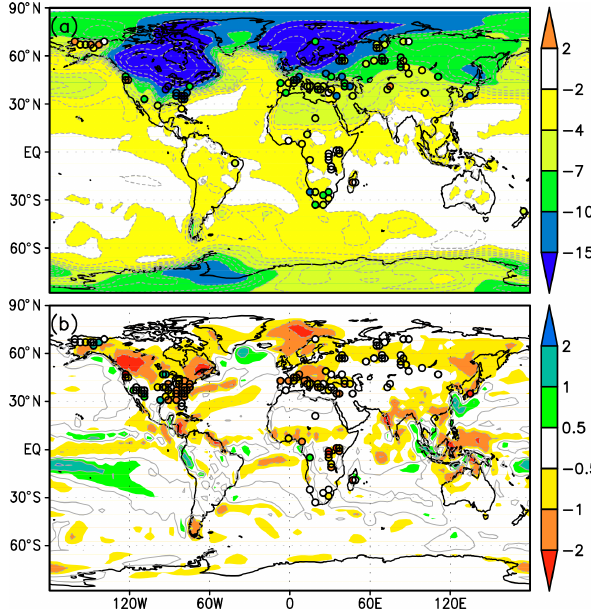
Figure 6. (a) Air temperature anomaly at 2m height (unit: ◦ C) and (b) precipitation anomaly (unit: mmd − 1 ). Anomalies are calculated as LGM relative to PI values. Circles denote values derived from proxy data (Bartlein et al.,